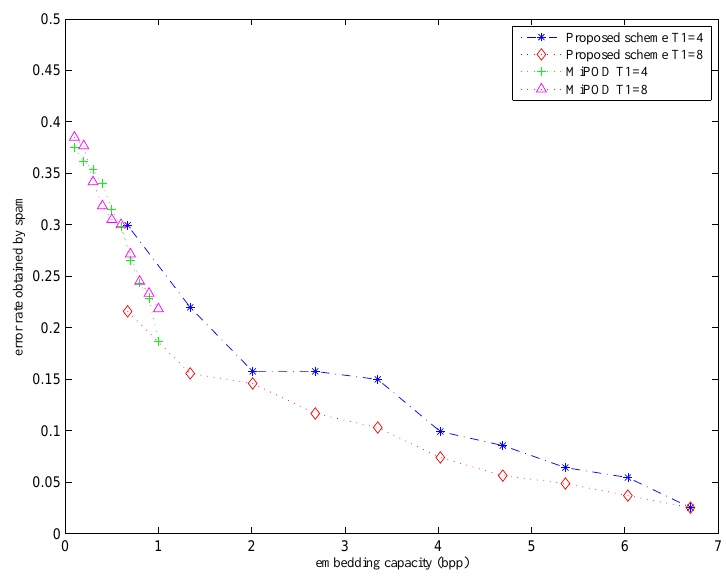
Figure 9. The simulation error rate between minimizing the power of the optimal detector (MiPOD) and the proposed scheme for subtractive pixel adjacency matrix